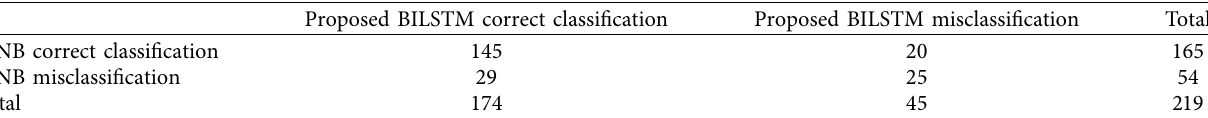
Table 11: F-S emotion class